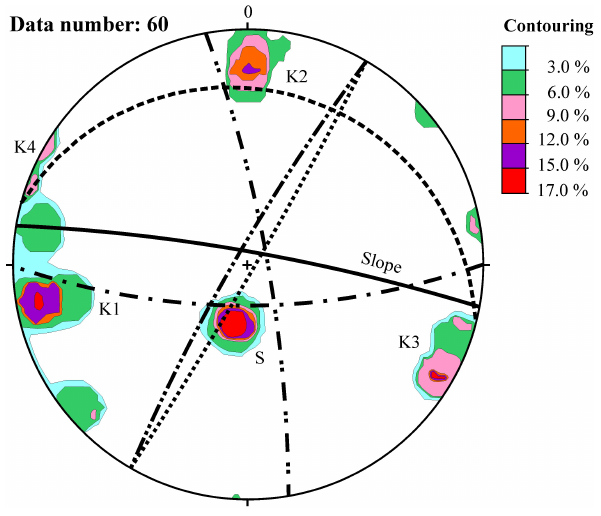
Fig. 7. Stereonet (Lambert-Schmidt equatorial net) of the joints affecting the cliff. S: bedding planes; K1–K4: joints.